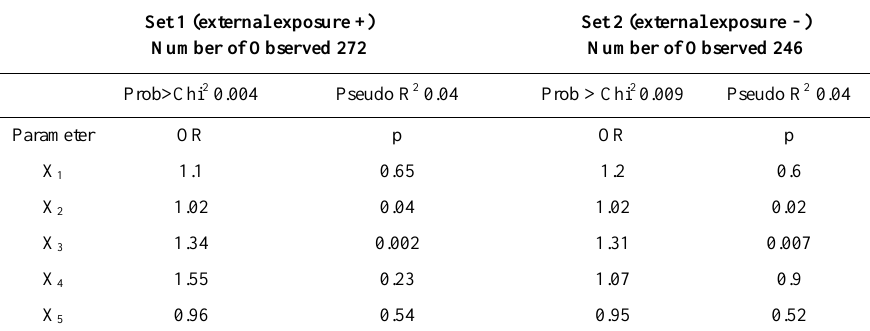
Table 5. Predictive risk factors and comparison of